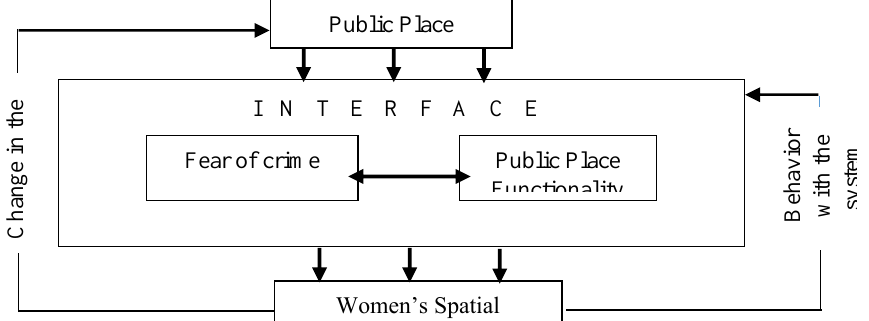
Figure 1. Women spatial behavior based on two factors of “fear of crime”, and “public place